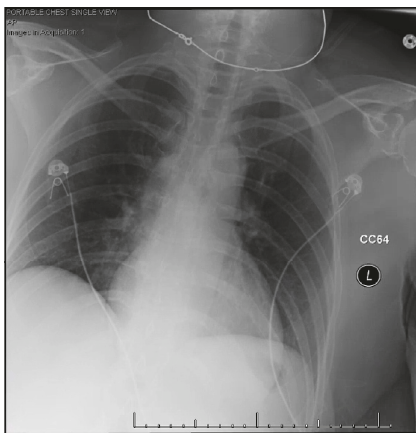
Figure 1: Presenting CXR showing no focal infiltrates or other evidence of cardiopulmonary disease.